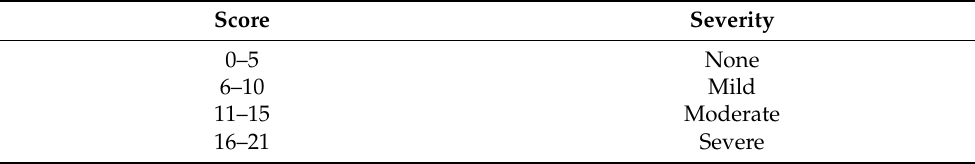
Table 1. GAD-7 anxiety scoring system in pregnant